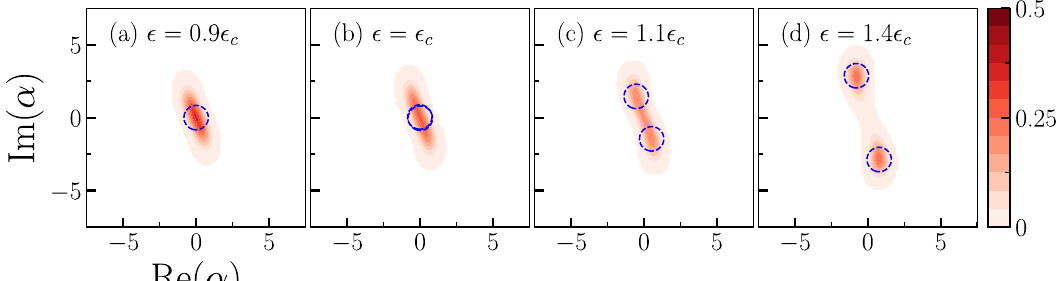
Fig. 1 Wigner function of the system steady-state. This has been obtained with numerical simulations of the full quantum model (colormap) and half-height contours (dashed blue circles) of the corresponding analytical solutions obtained under semi-classical approximation (see “ Methods ” ). The four sub plots are obtained taking ω = 1 Γ , χ = 0.04 Γ and for increasing values of the pump strength ϵ . The fi gure shows the transition from the normal ( a ) to the symmetry-broken [( c ) and ( d )] phases, taking place around the semiclassical prediction ϵ ¼ ϵ c ¼ ffiffiffiffiffiffiffiffiffiffiffiffiffiffiffiffi p ω 2 þ Γ 2 ( b ). The system is highly susceptible in the proximity of the criticality, and so it can be exploited in high-sensitivity magnetometry. Moreover, the system shows two highly distinguishable phases, corresponding to a vacuum-like ( a ) and displaced state ( d ), a feature that can be exploited in high- fi delity qubit